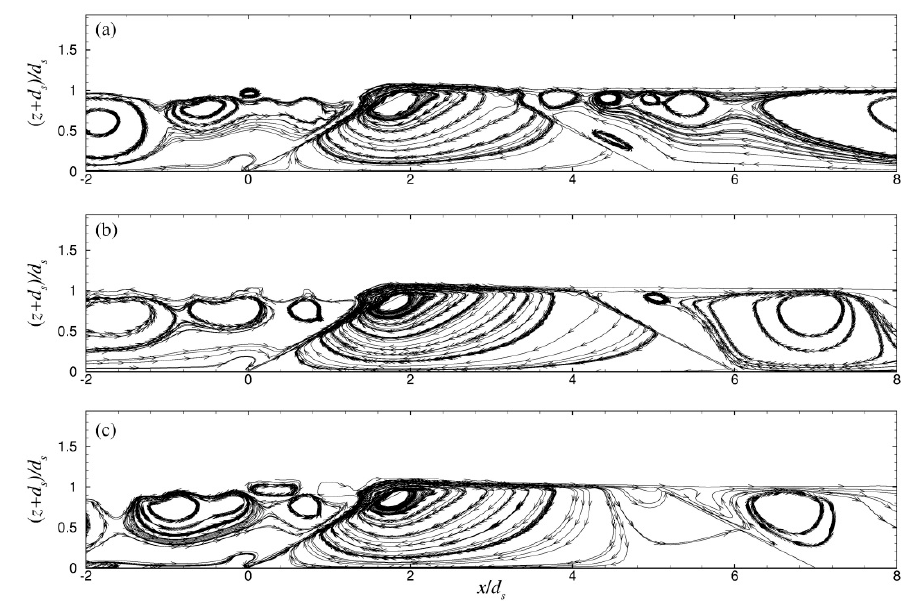
Figure 14. Streamlines in the vicinity of the ZFBs in cases: ( a ) 1, ( b ) 2, and ( c ) 3.